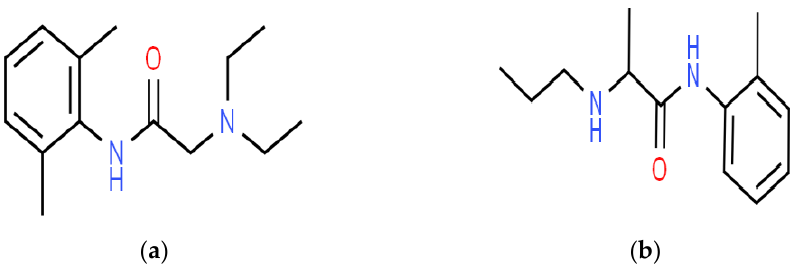
Figure 1. Chemical structures of ( a ) lidocaine and ( b ) prilocaine.